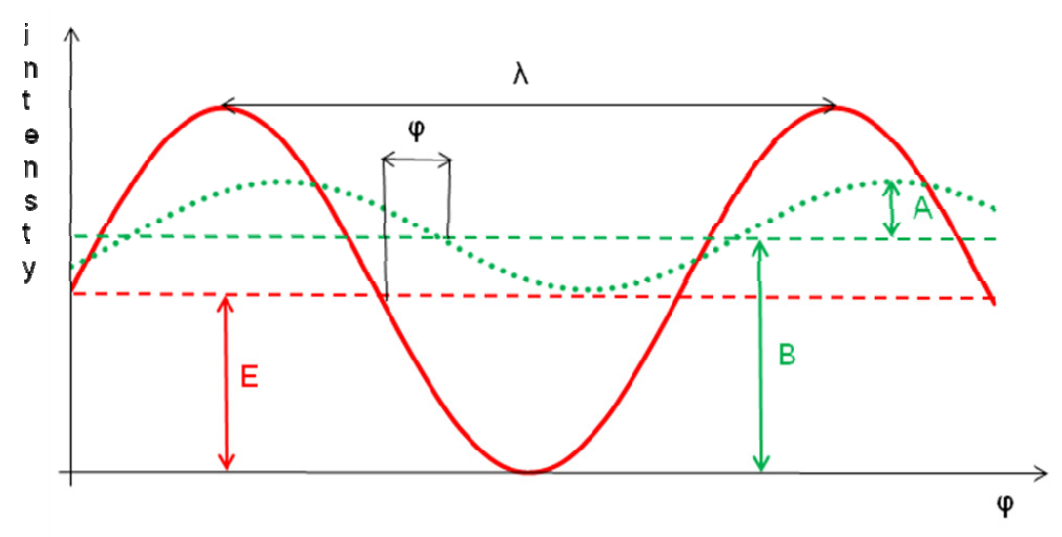
Figure 1. Scheme of the phase shift measurement principle (the solid curve represents the emitted signal while the dotted one represents the received